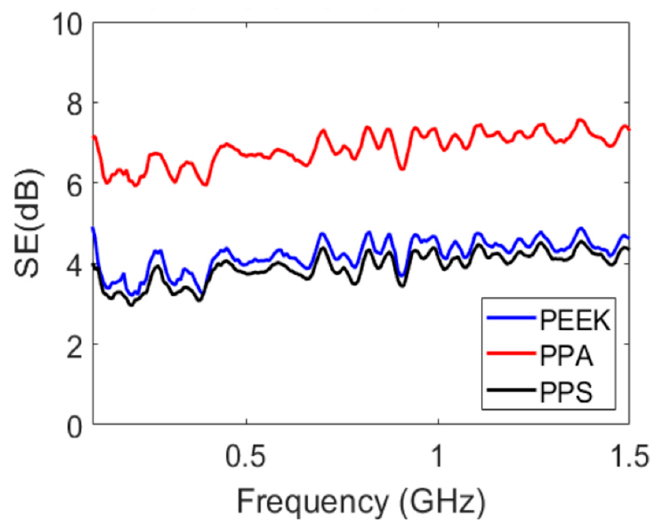
Figure 7. Simulation of the E-Field at 1.05 GHz for the PPS sample in the EMI fi xture.